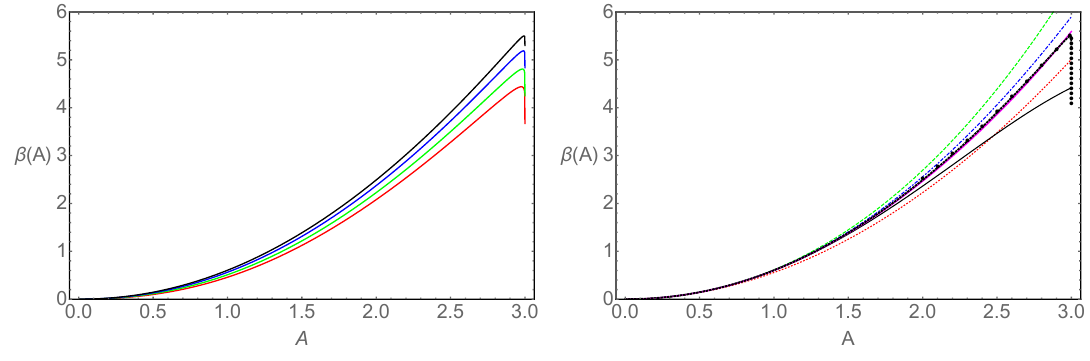
Figure 1 . Left: the beta function to (cid:12)rst order in 1 =N f for matter (cid:12)elds in the fundamental representation and N c = 3. From bottom to top the curves are for N f = 30 (red), N f = 40 (green), N f = 60 (blue) and N f = 100 (black). Right: the beta function at di(cid:11)erent loop orders of perturbation theory for N f = 100. The dotted (red), dashed (green), dash-dotted (blue), solid (black) and thick solid (magenta) lines correspond, respectively to one, two, three, four and (cid:12)ve loop results. The thick-dotted line is the beta function to leading order in 1 =N f